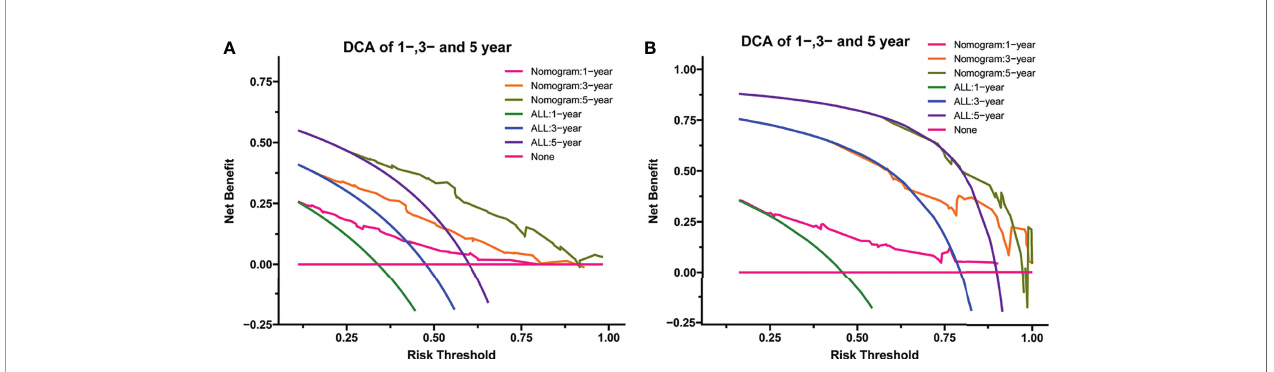
FIGURE 10 | The decision curve analysis of the nomogram for predicting 1-year, 3-year, and 5-year OS in the training set (A) and validation set (B) . OS, overall survival.